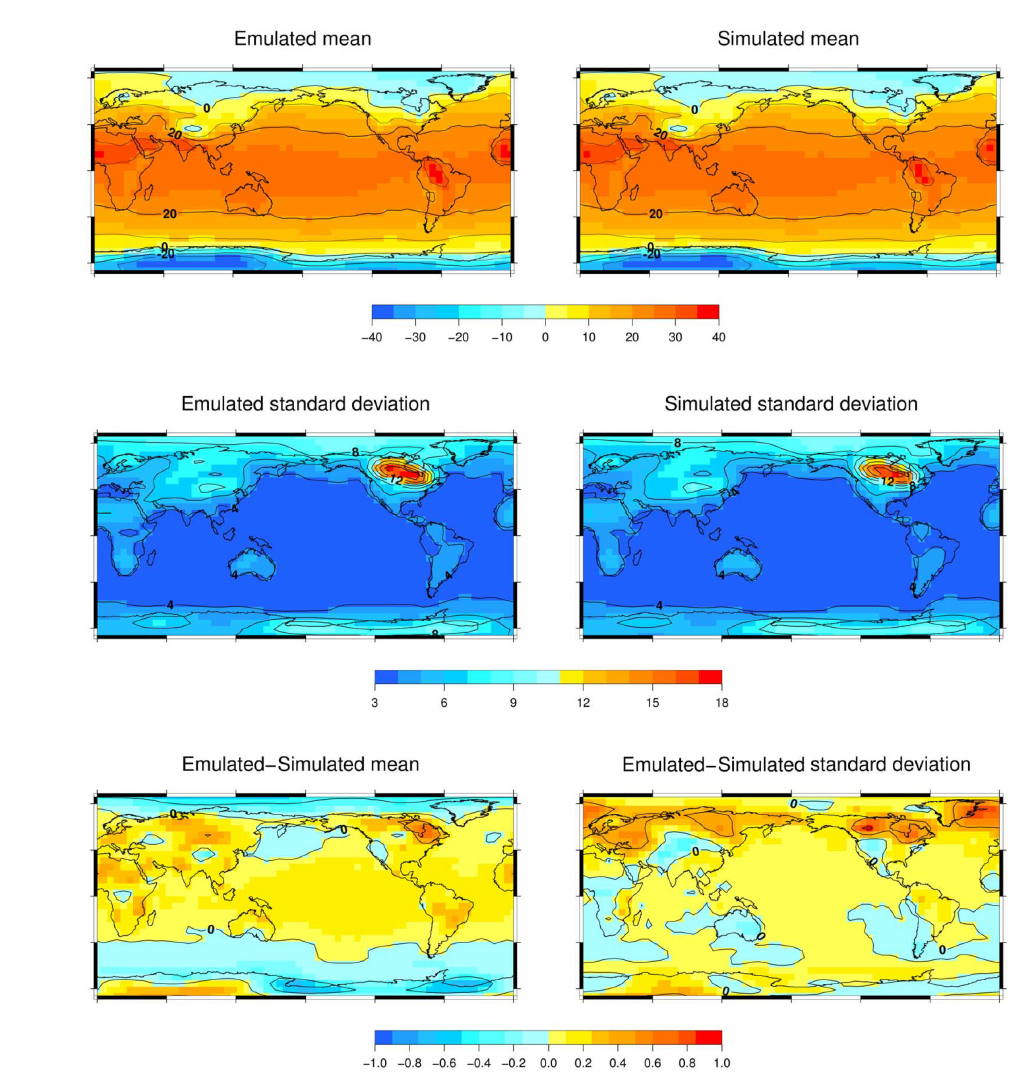
Figure 8. Mean and standard deviation of the emulated (upper and middle left) and simulated (upper and middle right) validating ensembles. The emulated–simulated differences in mean (lower left) and standard deviation (lower right) are also